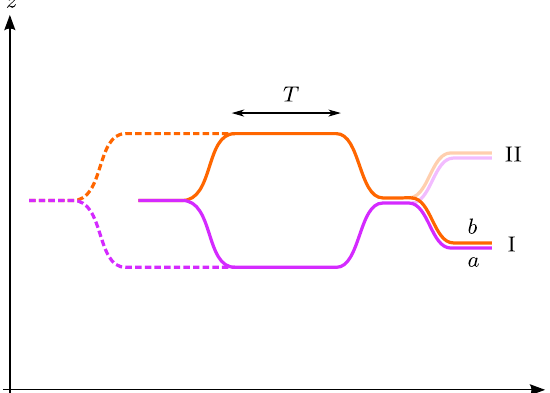
FIG. 6. Central trajectories in the laboratory frame for a guided interferometer where the wave packets are held at different constant heights for some time T . The effect of the gravitational redshift on the differential phase shift can be identified by comparing the outcome with another interferometer, where the holding time T is extended, while leaving everything else unchanged (dashed